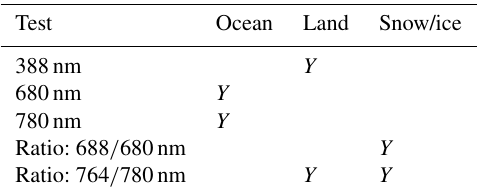
Table 2. Cloud masking tests for different surface